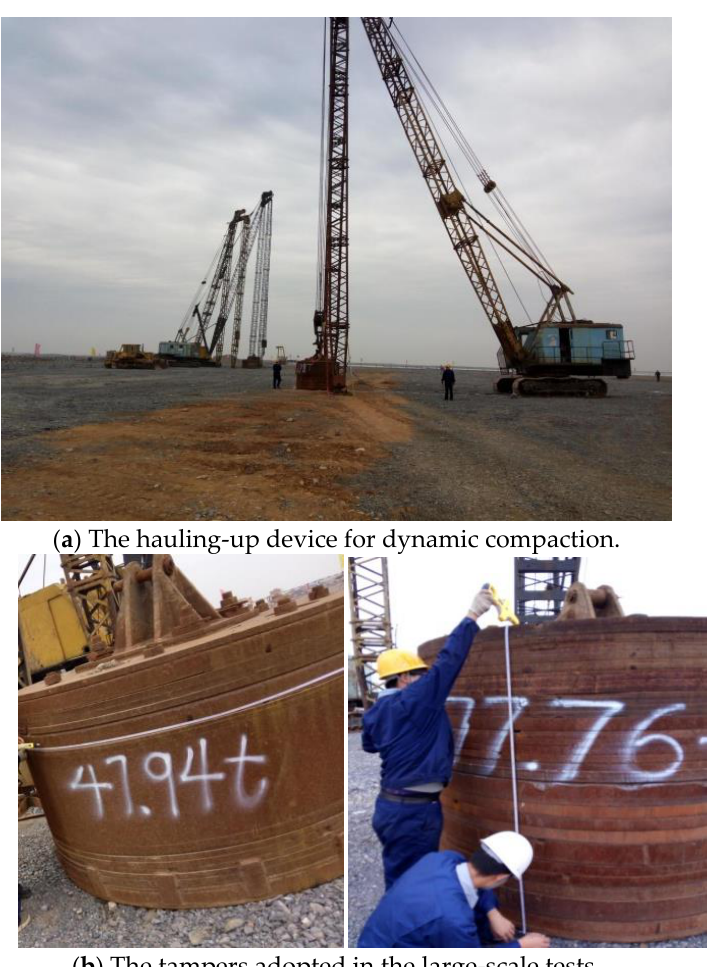
Figure 3. The device adopted in the large-scale tests of dynamic compaction. Considering the effect of different combinations of tamper weight and falling height on the DC efficiency [5,29], three groups of the tamper weight and the drop distance were adopted. They were 47.94 t × 20.86 m, 61.98 t × 16.14 m, and 77.76 t × 12.86 m. The tamping points were spaced 10 m and arranged in a square shape, as shown in Figure 4. Each tamping point was tamped ten times for each group and the crater depth in each tamping was detected with a levelling